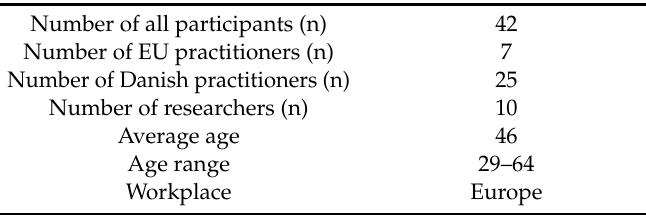
Table 4. Characteristics of